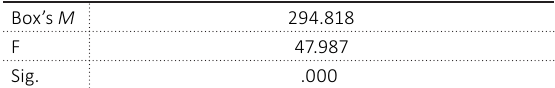
Table 4. Homogeneity of covariance